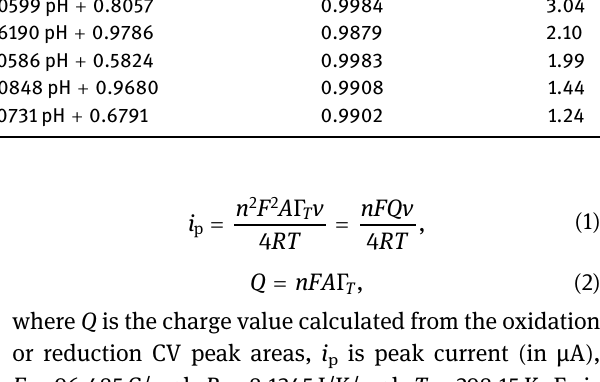
Table 4: The linear relationship between pH and peak potential E p of three polyphenolic compounds Matter Range of pH Linear regression equation r m GA 2.20 –